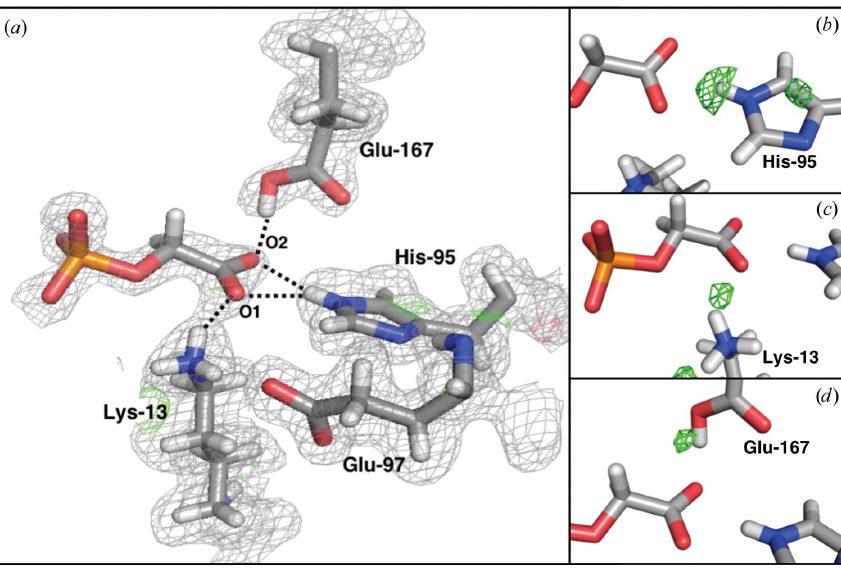
Figure 3 ( a ) Joint X-ray/neutron-refined structure of PGA–TIM with the 2 mF o (cid:5) DF c nuclear scattering- length density map contoured at 1.0 (cid:2) and the mF o (cid:5) DF c nuclear scattering-length difference density maps contoured at 3.0 (cid:2) (green) and (cid:5) 3.0 (cid:2) (red). ( b – d ) Nuclear scattering-length OMIT maps at 3.0 (cid:2) of the D atoms of three important residues in the PGA–TIM active site: ( b ) His95, ( c ) Lys13 and ( d )